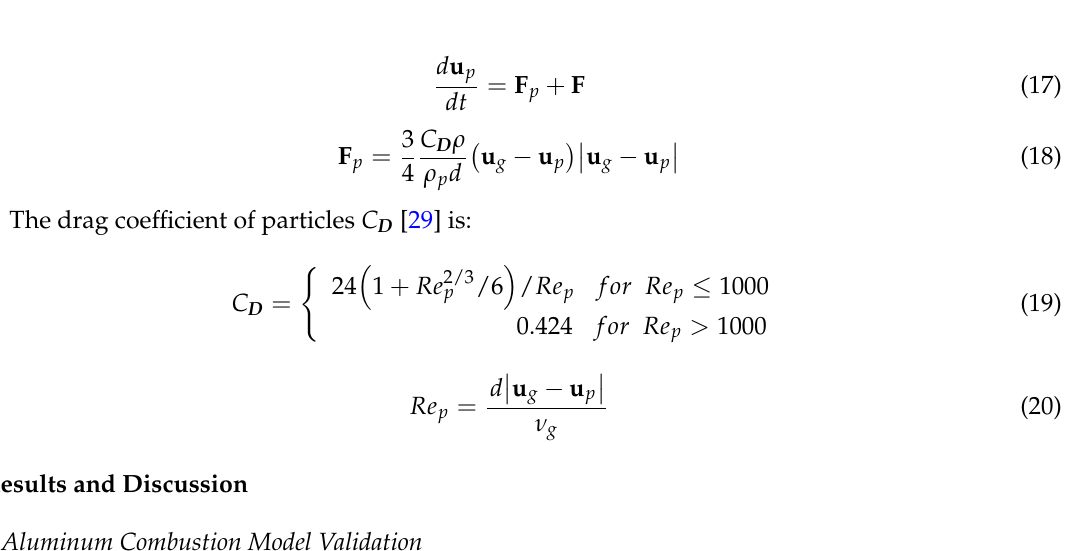
Figure 5. Particle temperature and mass ratio as a function of combustion time for Al particles. 3.2. Flow Field Analysis Figure 6 shows the temperature field distribution. The final temperature is about 3170 K, and this value is in agreement with the thermodynamic calculation results (3175 K). Figures 6a, 7 and 8 show that the low temperature areas are mainly distributed in the periphery and near the steam and aluminum particle inlet. However, the high temperature area is mainly located inside the cavity structure, which means the cavity region is the main combustion zone (Figure 7). According to the configuration, the steam is approximately tangential to the entrance of the combustion chamber to form a swirl flow firstly, and then moves from outside to inside, and finally flows out of the